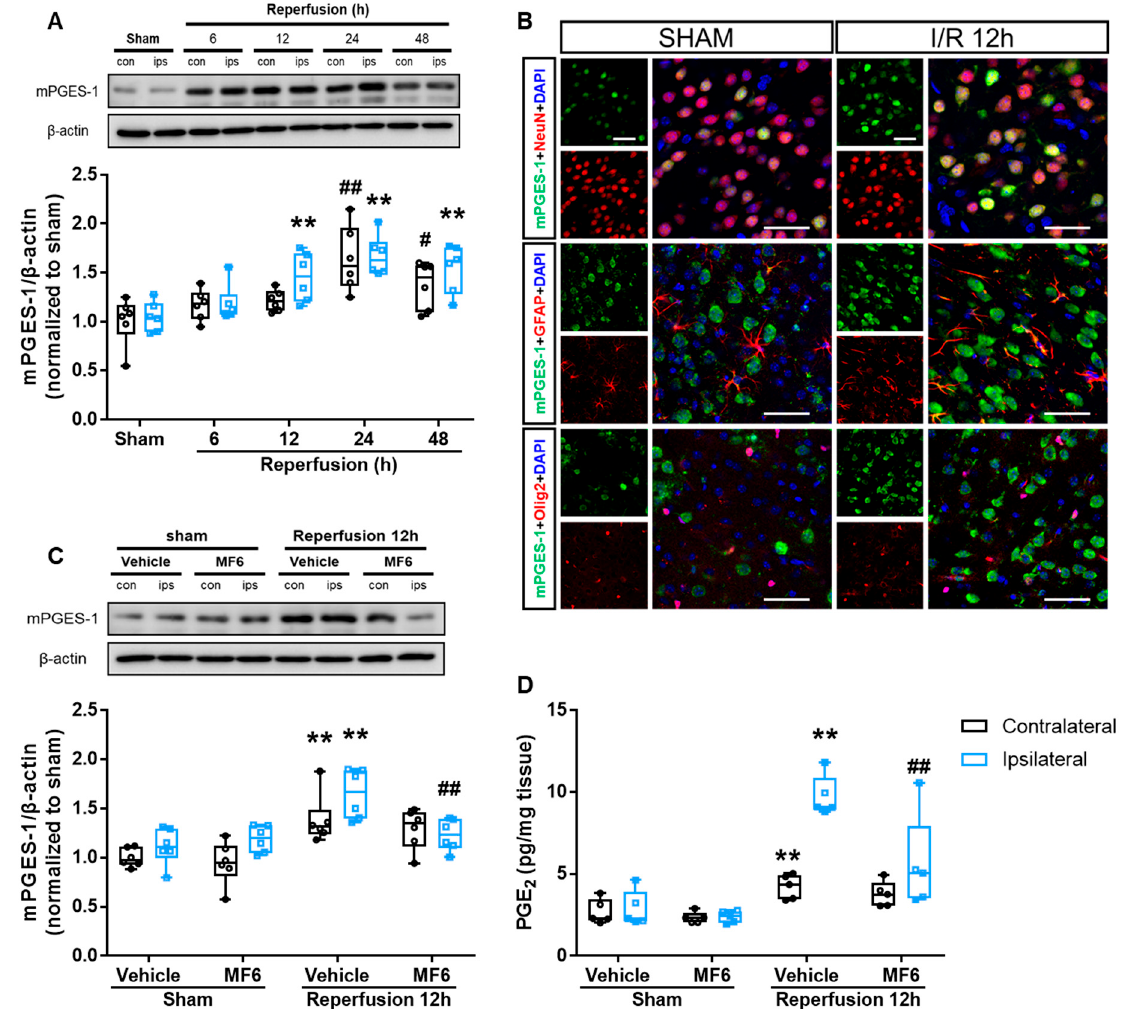
Figure 8. Effects of MF6 administration on mPGES-1 expression and PGE 2 levels in I/R mice. ( A ) Mice were subjected to tMCAO for 2 h. Representative Western blot images and quantitative analyses of mPGES-1 protein expression in contralateral and ipsilateral brain regions at 6, 12, 24 and 48 h after reperfusion. # p < 0.05, ## p < 0.01 vs. the sham group (contralateral); ** p < 0.01 vs. the sham group (ipsilateral) (n = 6 per group). ( B ) Representative micrographs of immunostaining for mPGES-1 (green) and NeuN, GFAP or Olig2 (red) in the cortical penumbra region at 12 h after reperfusion. Scale bar = 50 µm. ( C ) Mice were subjected to tMCAO for 2 h and administered 3 mg/kg MF6 at 30 min after reperfusion. Representative Western blot images and quantitative analyses of mPGES-1 protein expression in contralateral and ipsilateral brain regions at 12 h after reperfusion in I/R mice, treated with MF6 30 min after reperfusion (n = 6 per group). ( D ) PGE 2 levels in contralateral and ipsilateral regions (Figure 4A) of sham and I/R mice treated with or without MF6 (n = 5 per group). ** p < 0.01 vs. the sham-treated group, administered the vehicle (contralateral/ipsilateral); # p < 0.05, ## p < 0.01 vs. the I/R-treated group, administered the vehicle (contralateral/ipsilateral). Differences were statistically analyzed using one-way analysis of variance (ANOVA) followed by Dunnett’s test ( A ) or two-way analysis of variance (ANOVA) followed by Student–Newman–Keuls test ( C , D ).